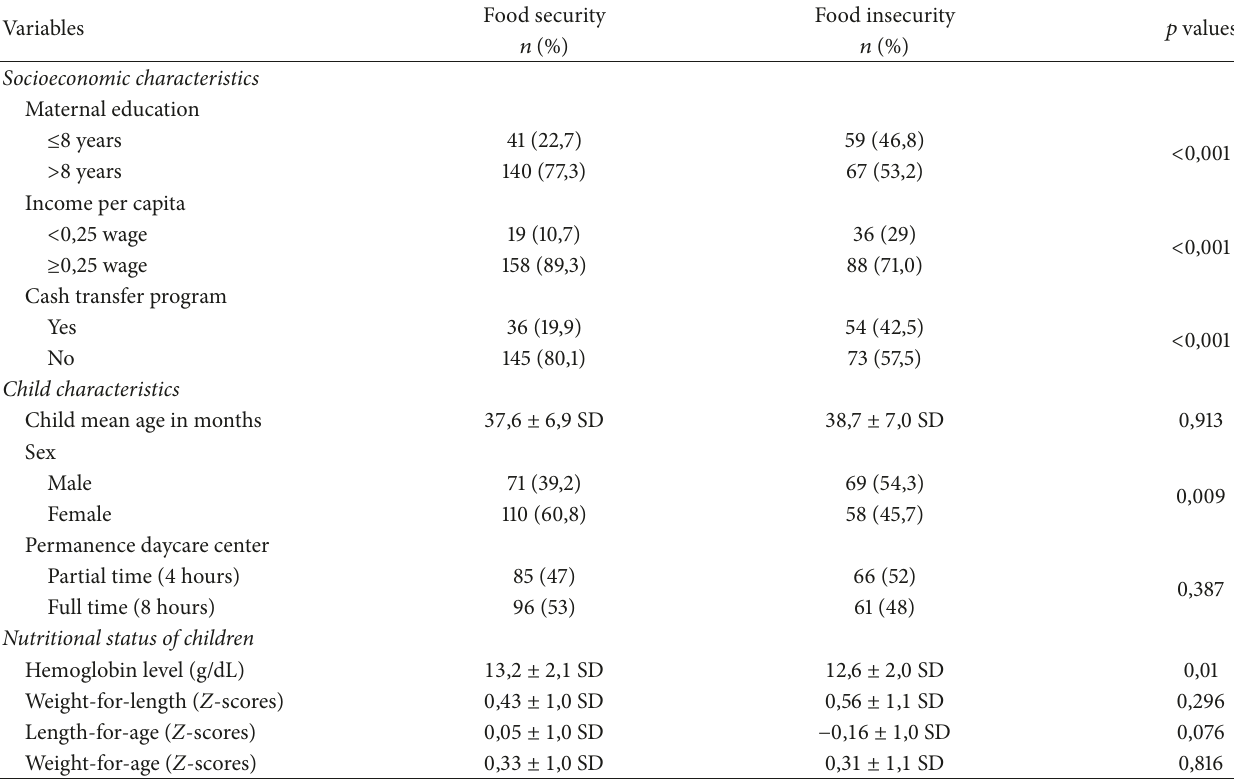
Table 2: Socioeconomic and demographic characteristics association with household food insecurity status. Taubat´e, S˜ao Paulo, Brazil, 2014. Variables